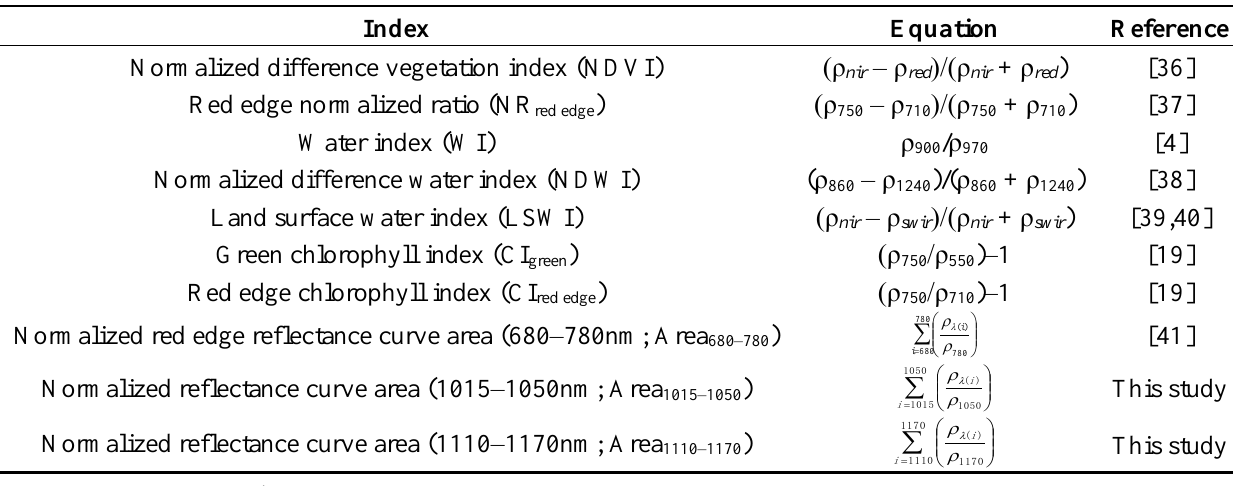
Table 3. Vegetation indices (VIs) used in the study and related source